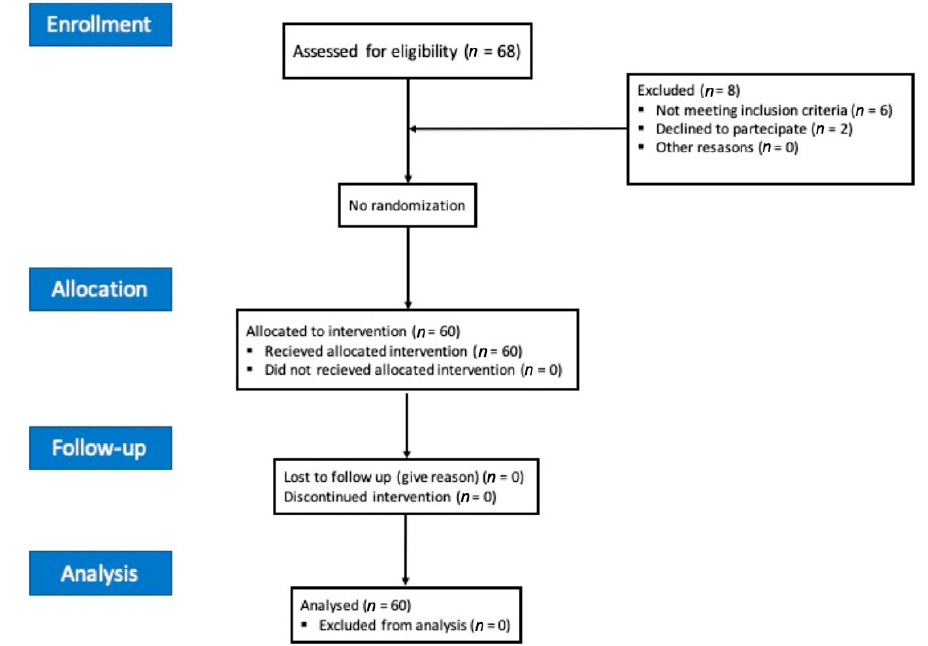
Figure 1. Consolidated Standards of Reporting Trials (CONSORT) 2010 flow diagram.